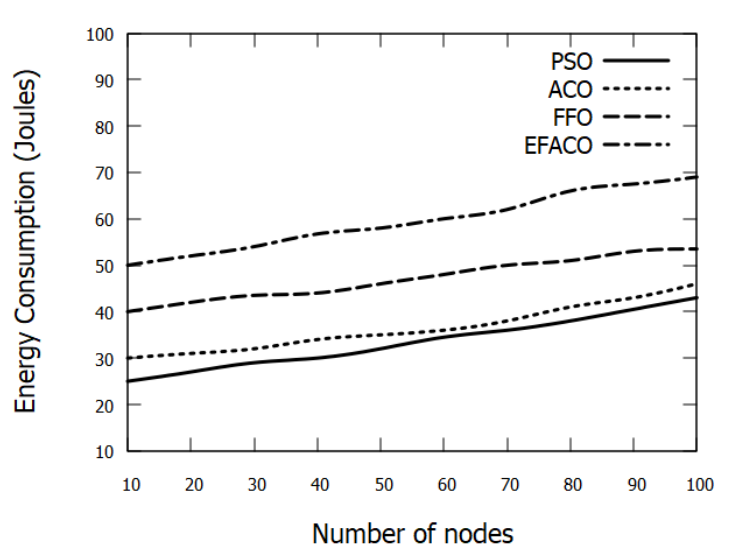
Figure 15. Comparison between proposed PSO, ACO, FFO, EFACO for Energy Consumption with a number of nodes. Table 5. Energy Consumption in (Joules) in Figure